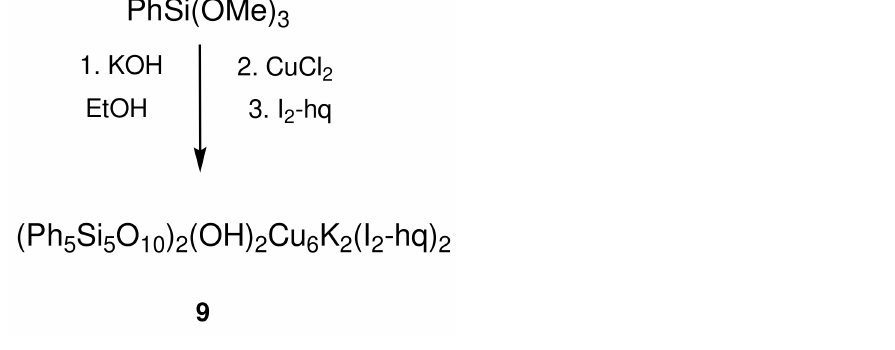
Scheme 5. General scheme of the synthesis of CuK-silsesquioxane/5,7-diiodo-8-hydroxyquinoline ligand complex 9 . Solvated molecules are omitted for clarity.